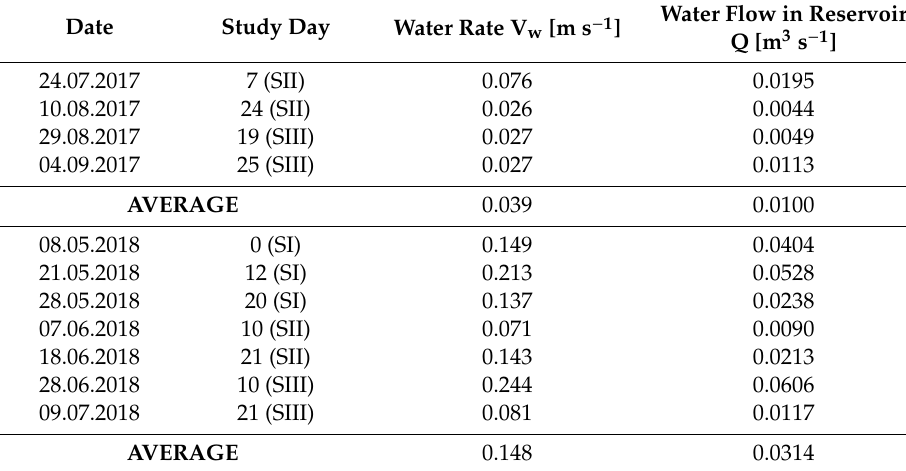
Table 4. Hydrological conditions during the study in 2017 and 2018.